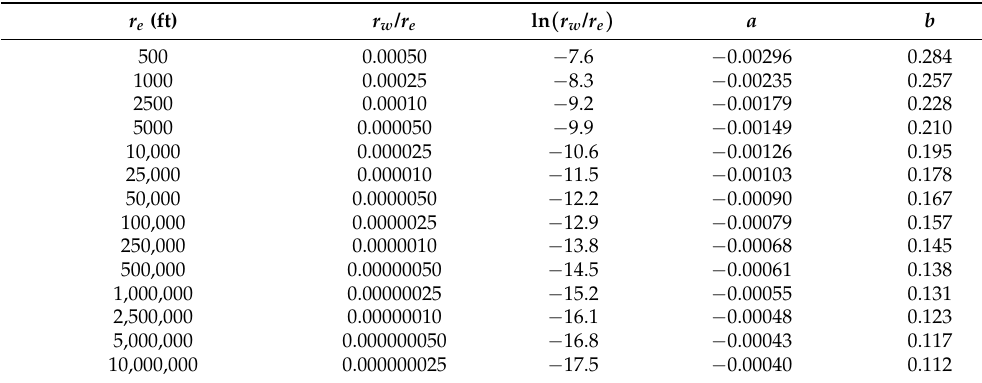
Table A1. Summary of fitting parameters a and b